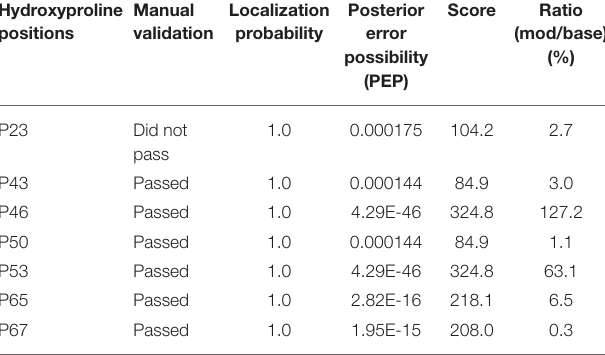
TABLE 3 | Hydroxyproline residues found in N. benthamiana -made rAra h 2.